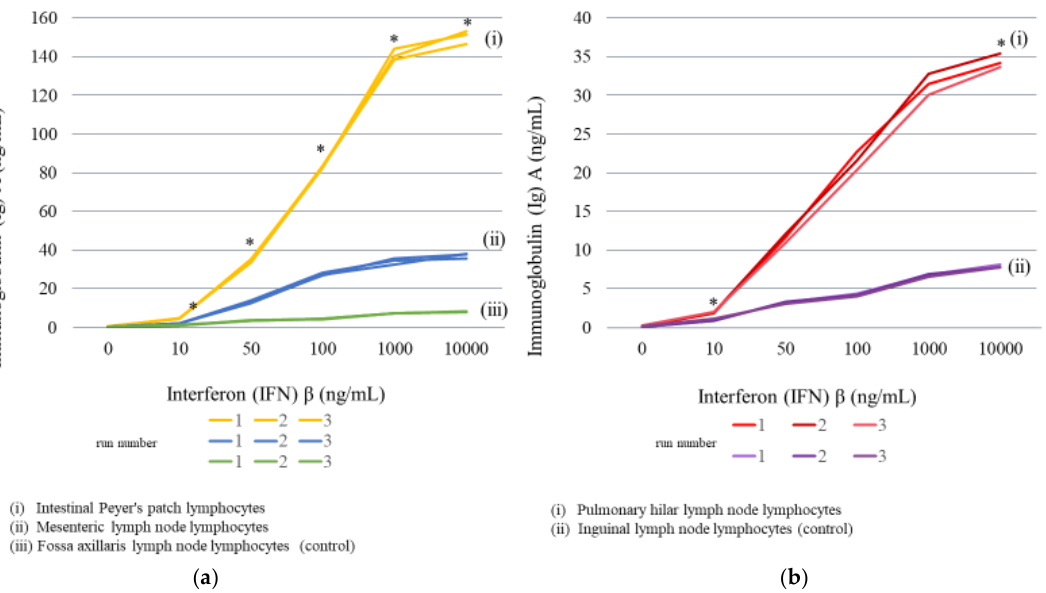
Figure 4. ( a ) Changes in IgA levels after addition of IFNβ to intestinal lymph node-related cultured cells: ( i ) Intestinal Peyer’s patch lymphocytes, ( ii ) mesenteric lymph node lymphocytes, ( iii ) fossa axillaris lymph node lymphocytes (control). ( b ) Changes in IgA levels after addition of IFNβ to respiratory lymph node-related cultured cells by concentration: (i) Pulmonary hilar lymph node lymphocytes, ( ii ) inguinal lymph node lymphocytes (control). * Indicates a significant difference between the groups, at p < 0.05 by the Games–Howell test.